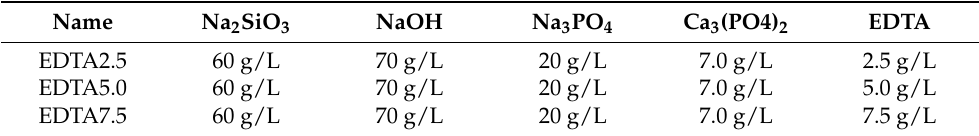
Table 1. Electrolyte composition and operation condition for the MAO